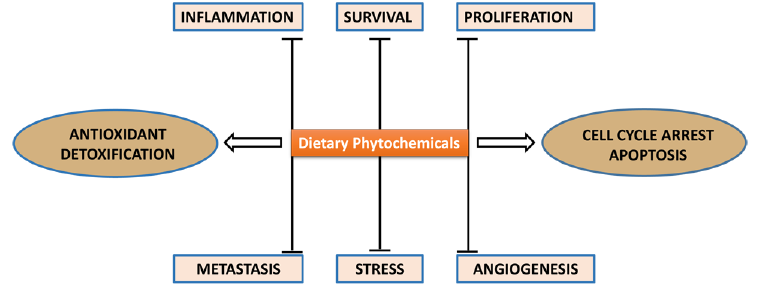
Figure 1. Schematic presentation of anticancer mechanisms of dietary agents in chemoprevention of